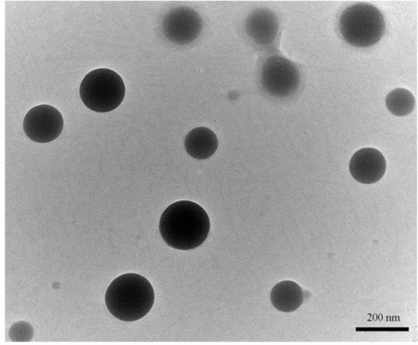
Figure 1. TEM images of DEX/CUR (scale bar 200 nm) showing microspheres with an average diameter of 290 nm. Scale bar 200 nm. Reproduced from [40]. MDPI